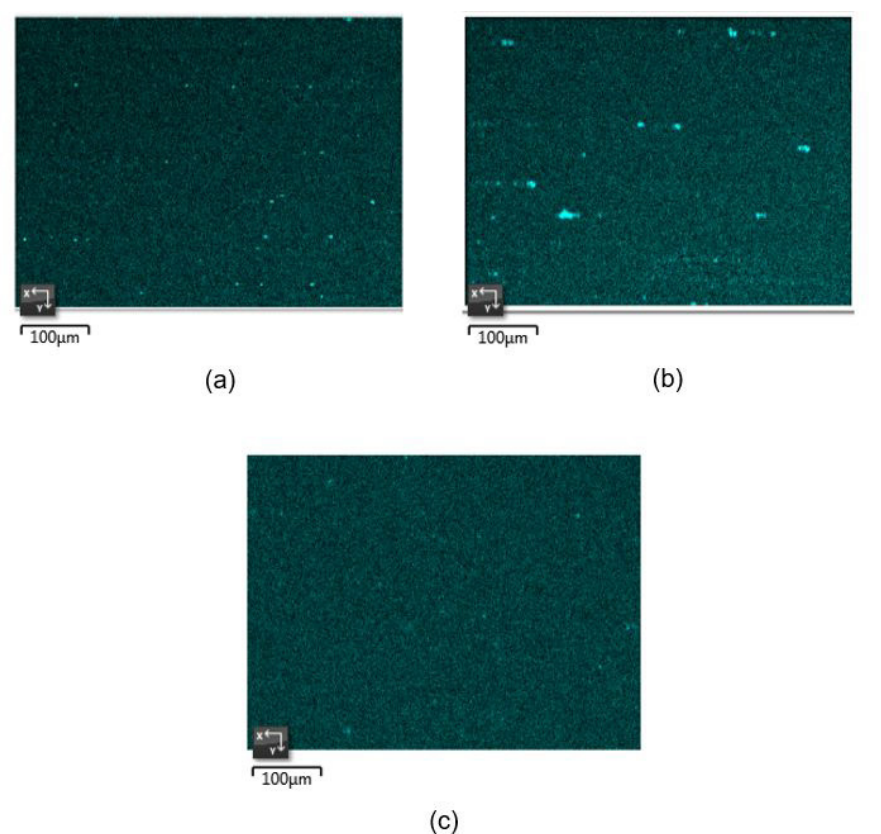
Figure 9. EDS X-ray elemental mapping of Cu-K of different welding zones: (a) BM, (b) HAZ and (c) SZ; indicating the microstructural evolution of Cu-rich